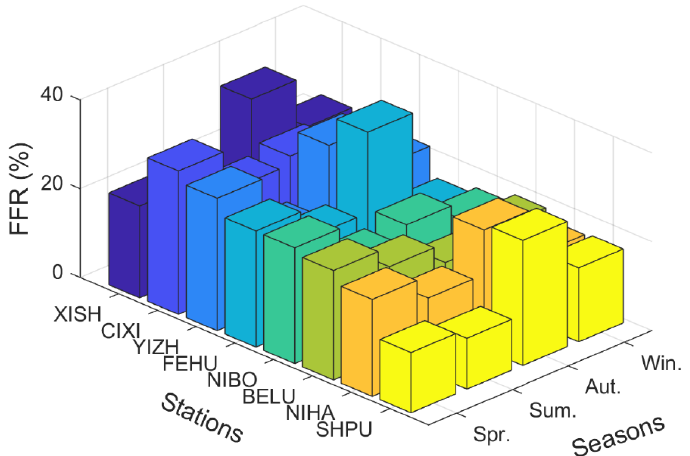
Figure 7. FFR statistics of the proposed rainfall early warning model at eight GNSS stations with different seasons. different seasons.